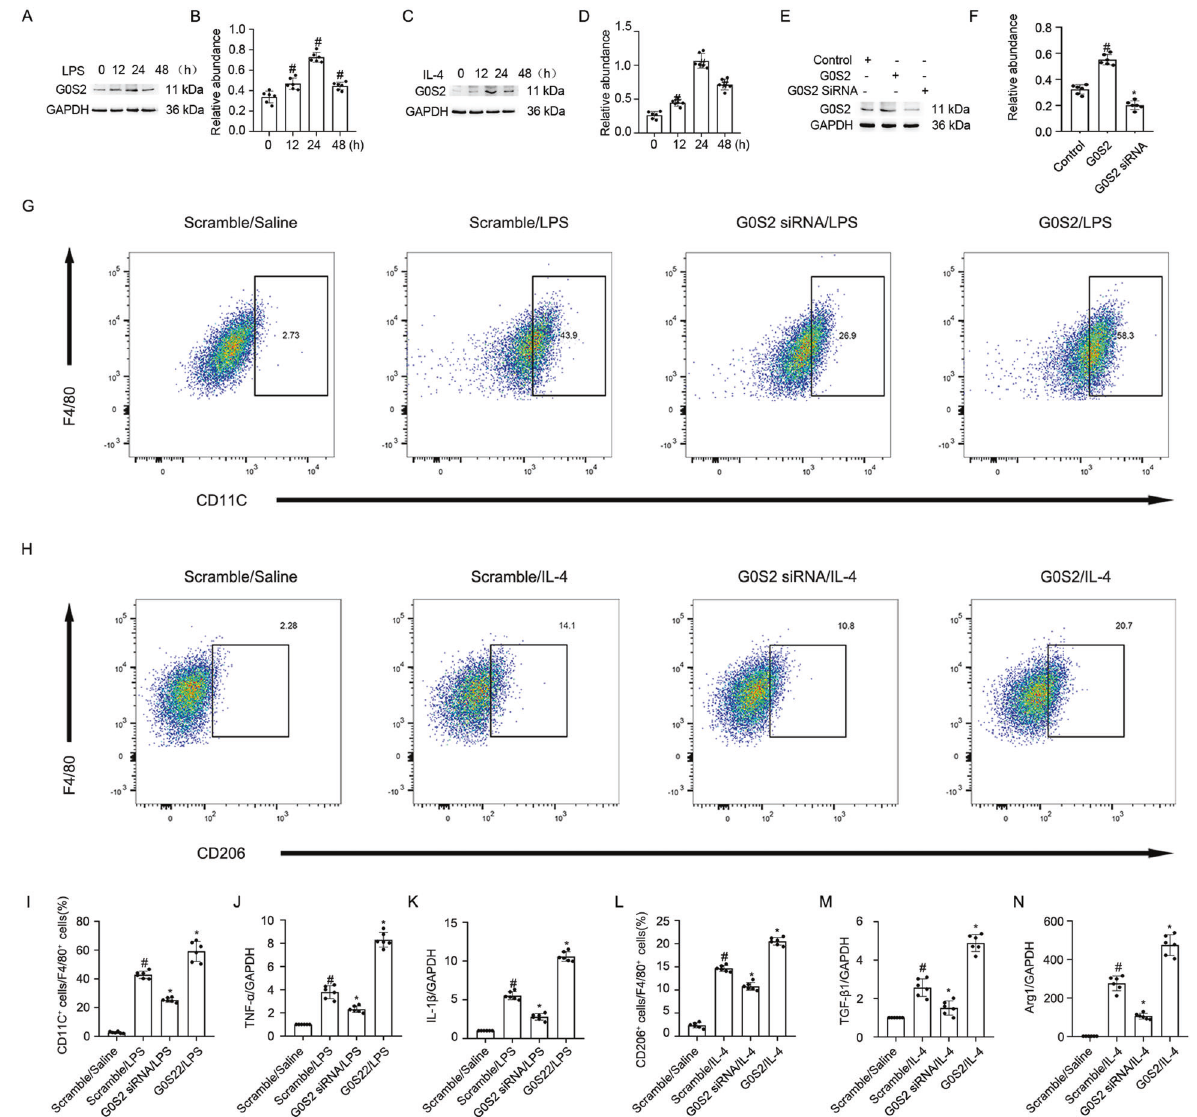
Fig. 5 G0S2 promoted transition of M0 macrophages to M1 or M2. RAW264.7 macrophage cells were transfected with G0S2 siRNA or G0S2 plasmid plus with LPS 1 μ g/ml or IL-4 20 ng/ml treatment for 24 h. A , C , and E Representative immunoblots of G0S2 and GAPDH. B , D , and F Densitometry analysis of proteins levels, and normalized to internal control of GAPDH. G and I Representative FCM analysis the ration of M1 (CD11C + cells vs. F4/80 cells). H and L Representative FCM analysis the ration of M2 (CD206 + cells vs. F4/80 cells). J The expression levels of TNF- α were detected by real-time qPCR. K The expression levels of IL-1 β were detected by real-time qPCR. M The expression levels of TGF- β 1 were detected by real-time qPCR. N The expression levels of Arg1 were detected by real-time qPCR. Data are expressed as means ± sd ( n = 6). # P < 0.05 versus Scramble. * P < 0.05 versus LPS or IL-4